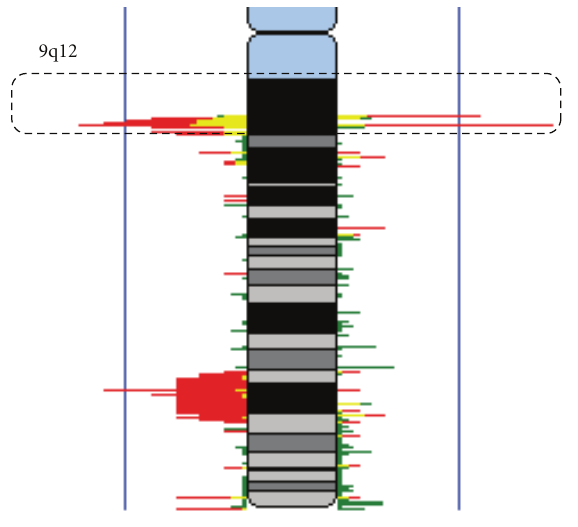
Figure 2: DNA copy-number alteration at chromosome 9q in arsenic-exposed lung SqCC. CNA frequencies are overlaid in this karyogram. Profiles of 52 lung SqCC biopsies were generated using a submegabase resolution tiling-set rearray (SMRTr) platform. Twenty-two arsenic-exposed samples (shown in red) were obtained from lung cancer patients from northern Chile. Thirty samples from patients without known arsenic exposure (green) were obtained from North American individuals. Regions in yellow denote a sector of overlapping alteration status in both groups. The magnitude of red, green, and yellow bars represents percentage of samples (0–100%, with blue vertical lines representing 50% frequency) exhibiting DNA gains (to the right) and DNA losses (to the left). Dotted line represents 9q12